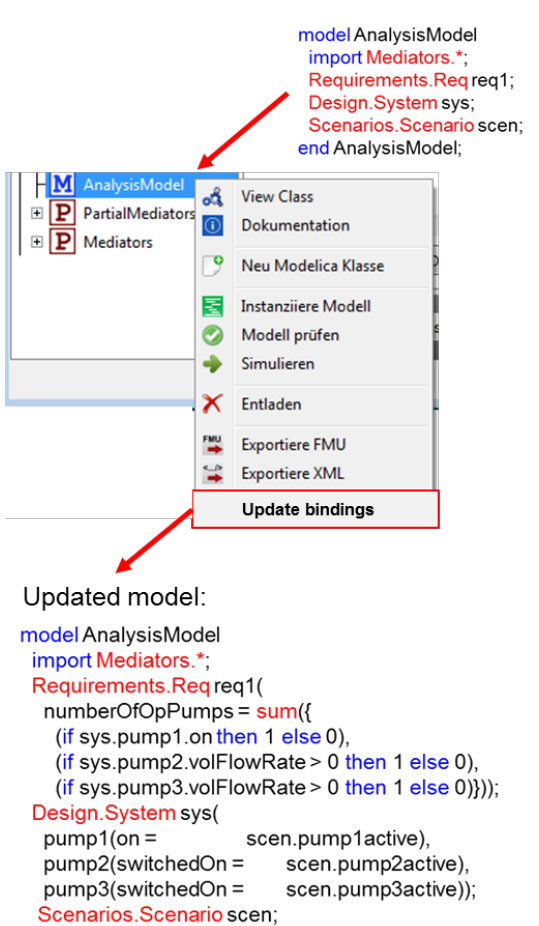
Figure 5: The information that needs to be captured in abstract syntax.